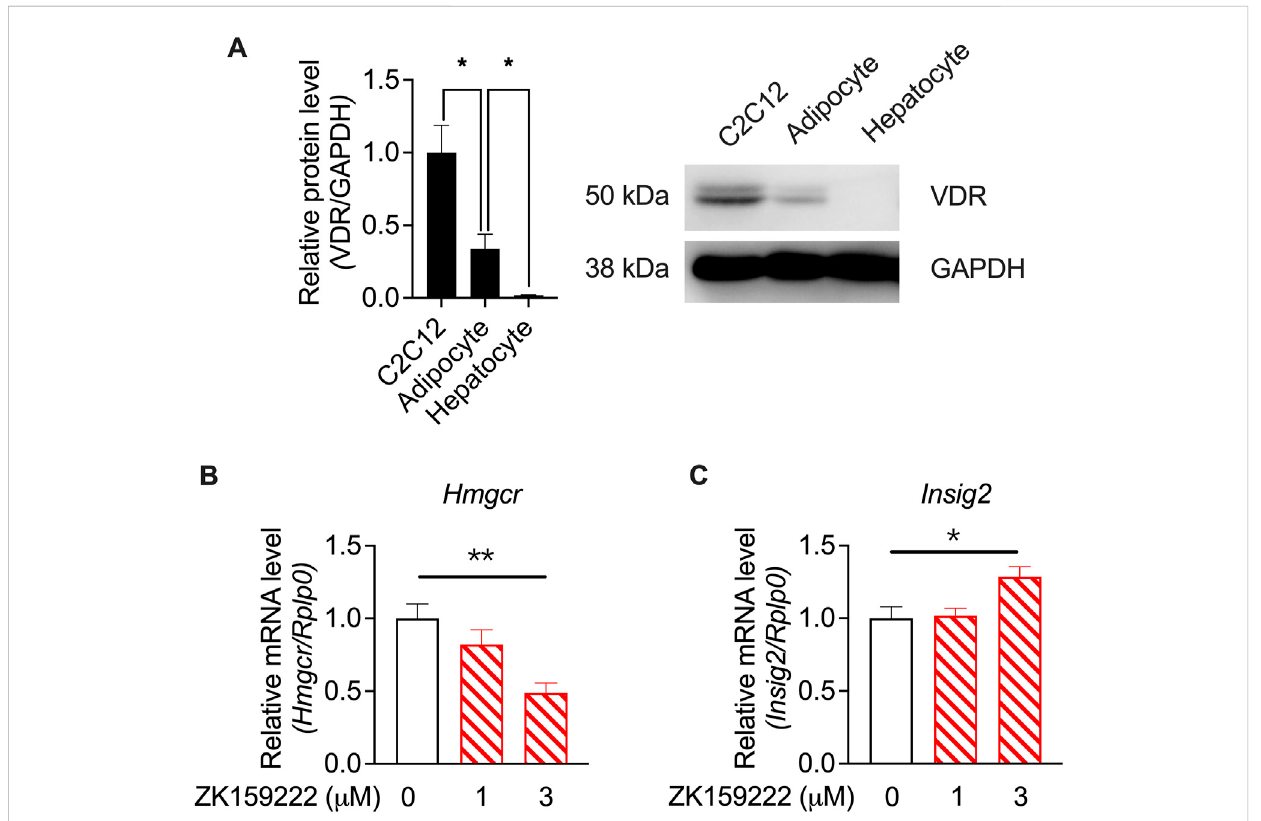
FIGURE 7 Validation by quantitative RT-PCR results showing calcitriol regulating the cholesterol biosynthesis-associated genes mediated by VDR in the C2C12 cell line. (A) The results of vitamin D receptor (VDR) protein levels in C2C12 cells, adipocytes, and hepatocytes, normalized to glyceraldehyde 3- phosphate dehydrogenase(GAPDH) ( n =3). (B) Hmgcr and (C) Insig2 werevalidatedinZK159222withgradient-changedconcentrationsincreasingfrom 0to3 μ M( n =6).Dataareshownasmeans±SEM.* p < 0.05,** p < 0.01.Thevalidationofthedose-dependenteffectsofZK150222wascomparedby one-way analysis of variance